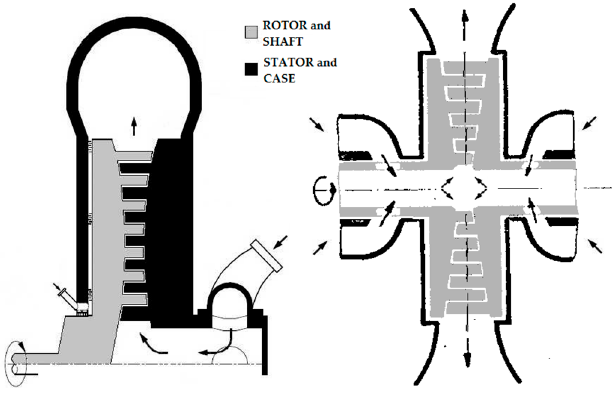
Figure 1. Ljungström Radially Outward Turbine (ROT): Fixed and Counter-rotating arrangements [7,8].